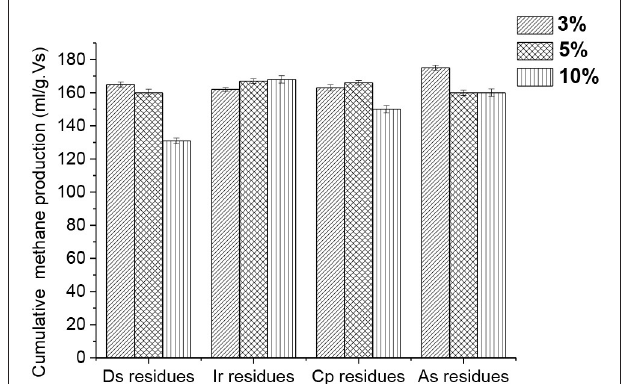
FIGURE 3 | Cumulative methane production affected by the addition of different HPR in different ratios.